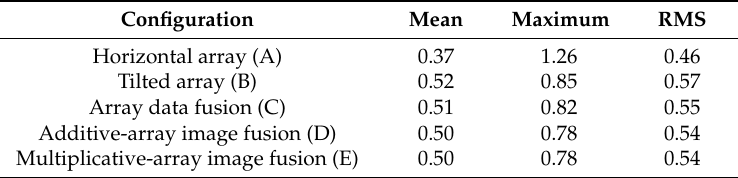
Table 2. Localization error indicators in meters: UWB source.